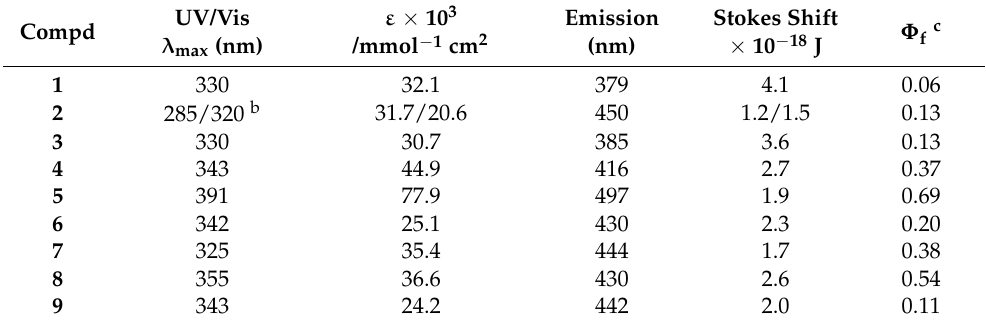
Table 1. Electronic absorption data a , absorption maxima, and fluorescence data of benzothiazoles 1 – 9 .